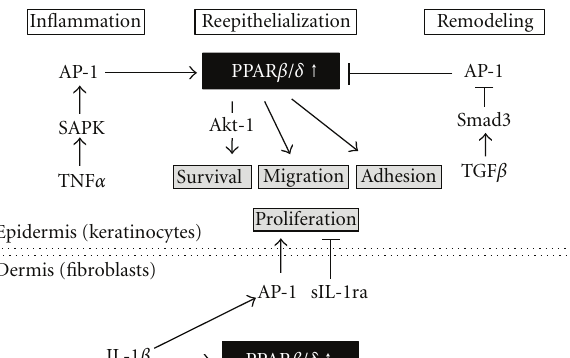
Figure 3: Role of PPAR β / δ expression in the wound healing processes after tissue injury. See text for detailed explanations. Abbreviations: PPAR , peroxisome proliferator-activated receptor ; TNF α , tumor necrosis factor α ; SAPK , stress-associated protein kinase ; AP-1 , activator protein-1 ; PPAR , peroxisome proliferator-activated receptor ; TGF β , transforming growth factor β ; IL-1 β , interleukin-1 β ; sIL-1ra , soluble interleukin-1 receptor antagonist